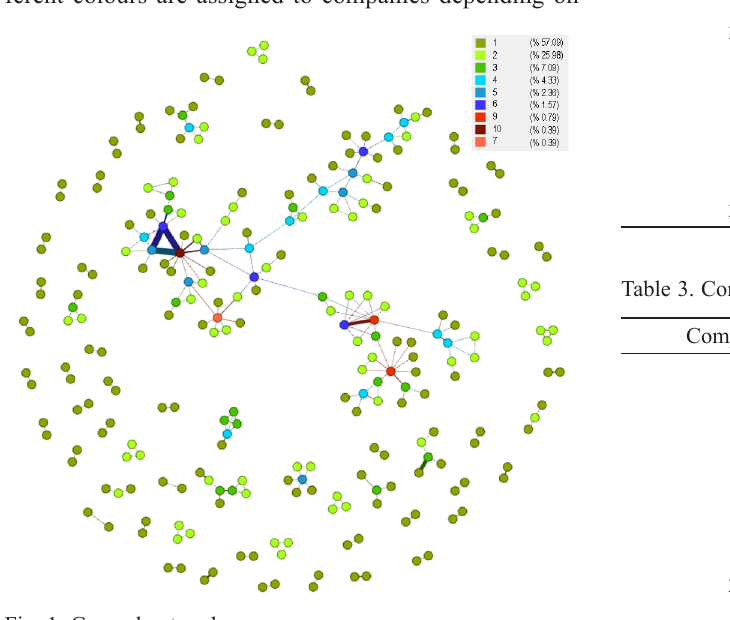
Fig. 1. General network